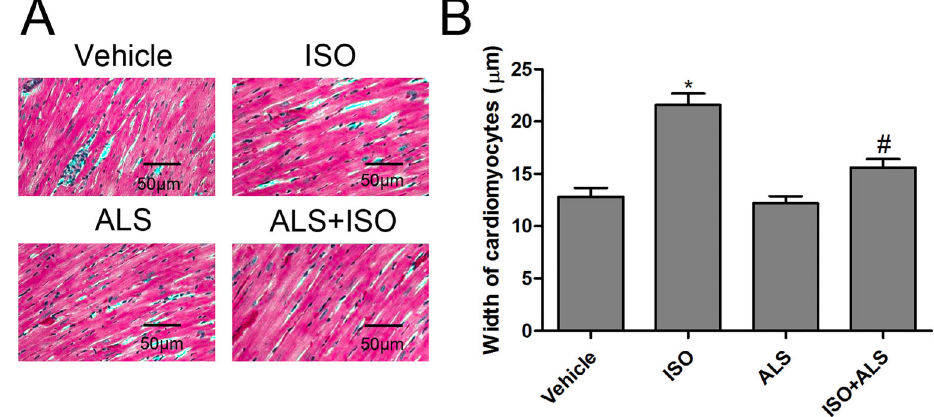
Figure 1. Effect of aliskiren (ALS) on cardiomyocyte size in isoproterenol (ISO)-treated rats. A , Hematoxylin and eosin staining was performed and ( B ) the width of cardiomyocytes was measured (n=6 per group). Data are reported as means ± SE. *P o 0.05 compared with vehicle; # P o 0.05 compared with the ISO-treated group (ANOVA followed by Tukey ’ s post hoc test).